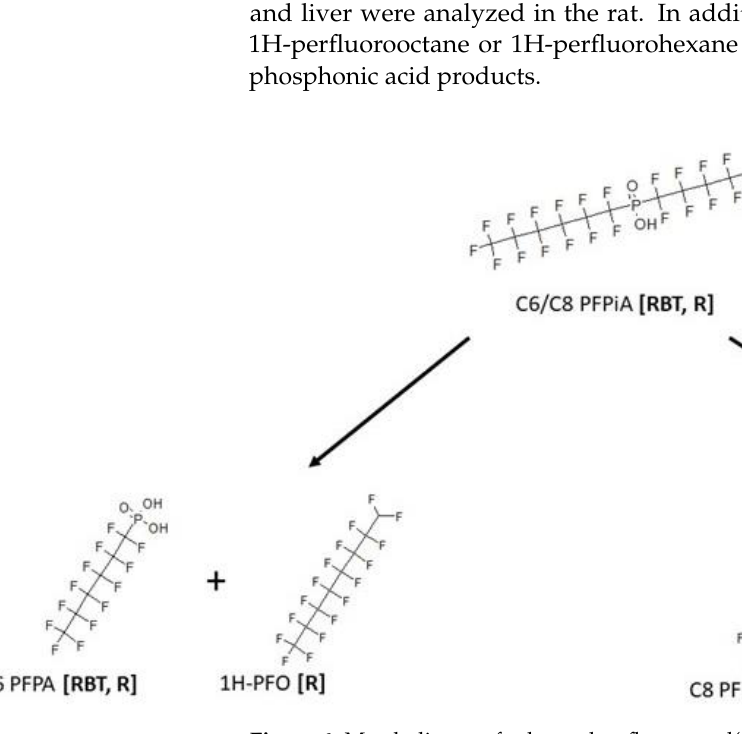
Figure 6. Metabolic map for heptadecafluorooctyl(tridecafluorohexyl)phosphinic acid (C6/C8 PFPiA) as found in rainbow trout [16] and rat [17].